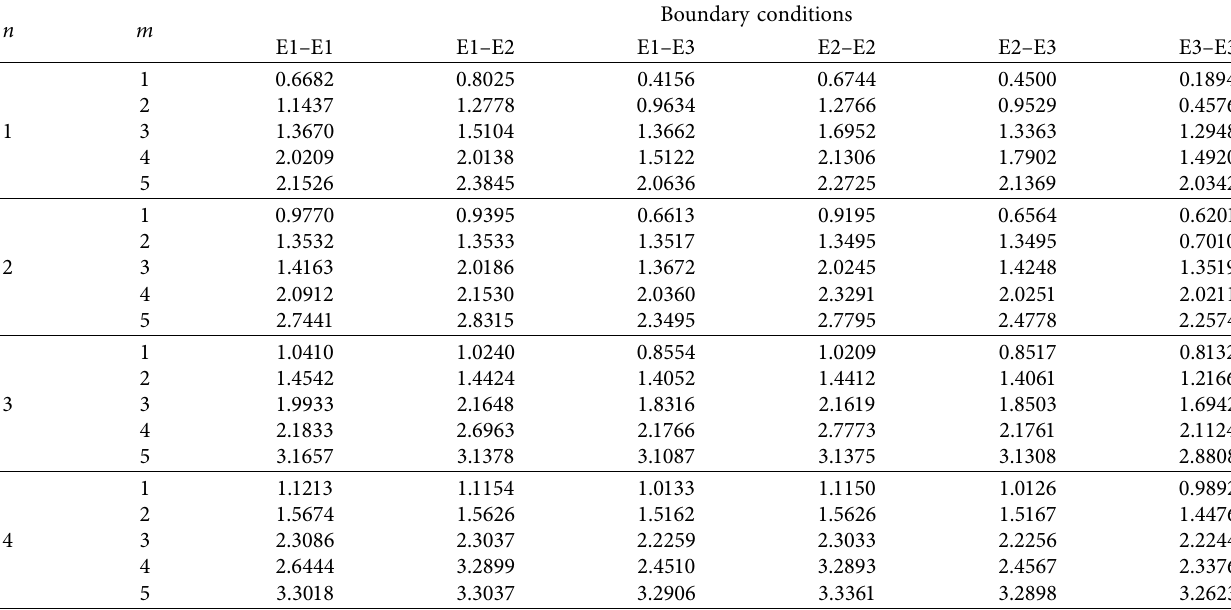
Table 5: Results of annular spherical shell with elastic boundary conditions ( φ 0 � π /6, φ 1 � π /2, h � 0.06m, and R �